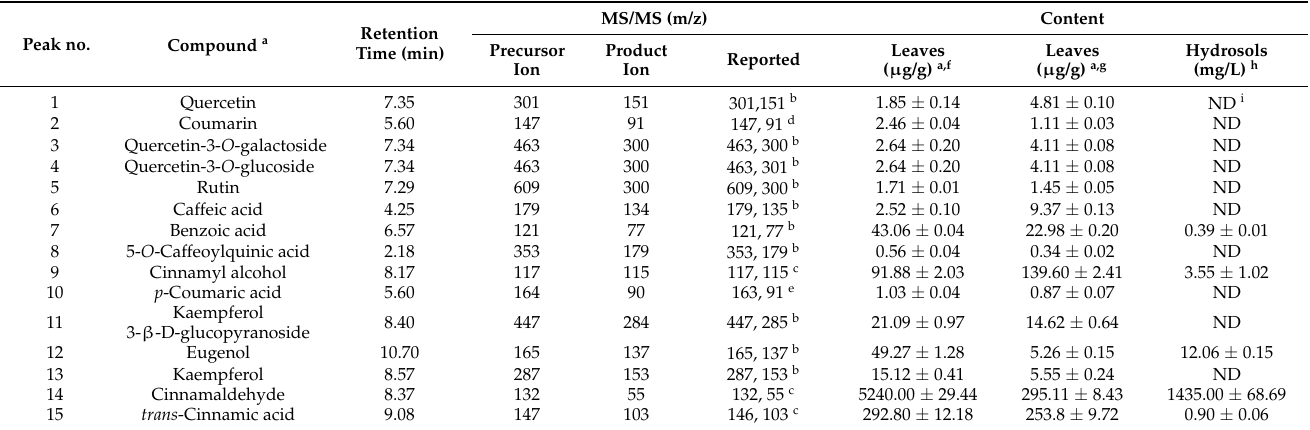
Table 4. Identification and quantitation data of cinnamaldehyde and the other bioactive compounds in C. osmophloeum leaves and hydrosols by UPLC-MS/MS.